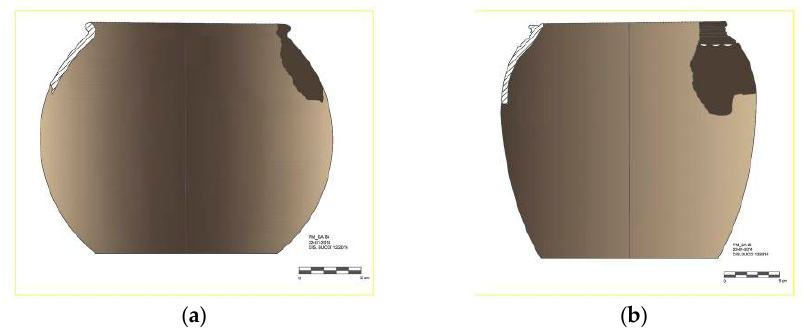
Figure 22. Digital reconstruction from diagnostic fragments of Late Roman-Mediaeval cookware found in Lago Tramonto, Gambulaga, Portomaggiore (FE, Italy): ( a ) Olla with a round lip and spherical body; ( b ) Olla with a flat lip and geometrical decorations on the shoulder (Giovanna Bucci).